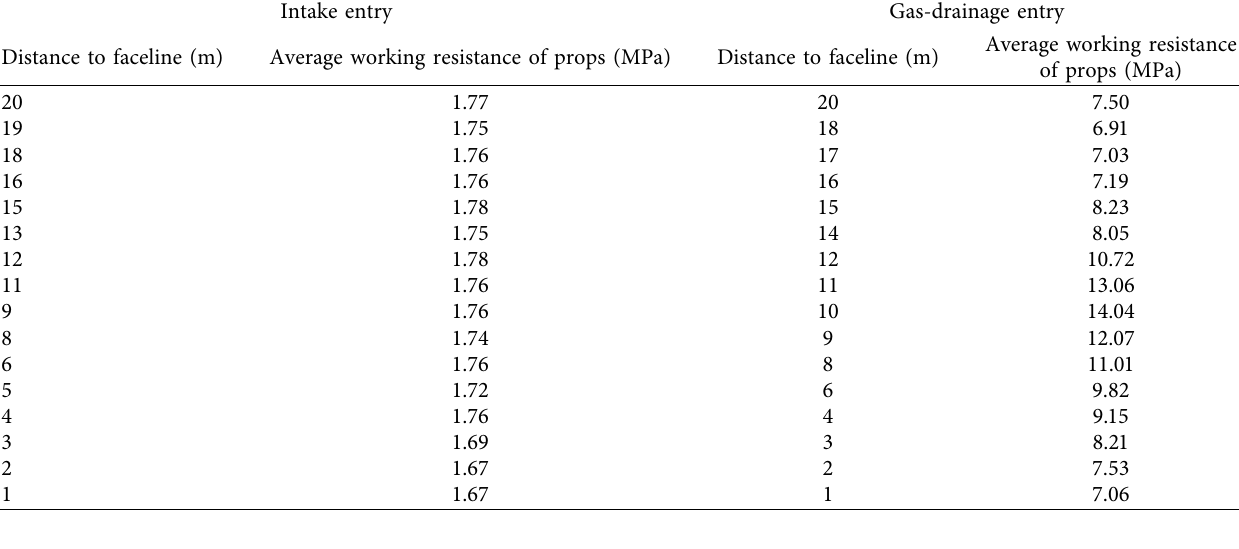
Table 1: Front abutment in two gateroads of 18111-1 panel of Zhenchengdi coal mine.